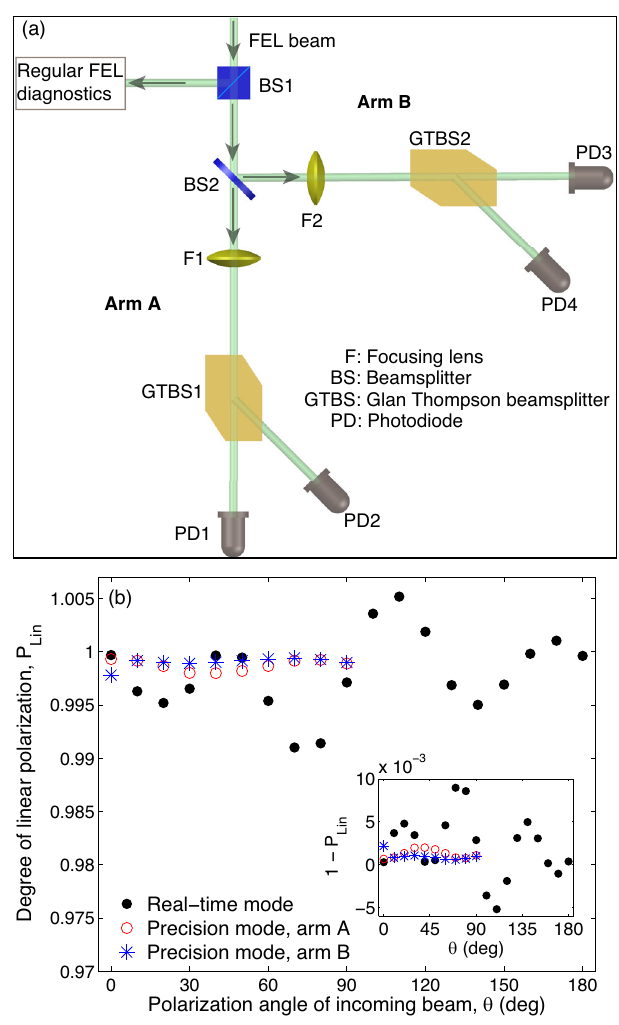
FIG. 3. (a) Layout of the new FEL polarimeter. After the FEL beam passes through a nonpolarizing beam splitter (BS1), it is split into two arms by a second nonpolarizing beam splitter (BS2), each comprised of a focusing lens, a Glan Thompson beam splitter, and two photodiodes. (b) Measured degree of linear polarization P in different operational modes when the incom- lin ing beam has nearly perfect linear polarization as it is prepared using a high-quality linear polarizer. The inset shows the ¼ 1 − P deviation from a perfect linear polarization, Δ P lin lin